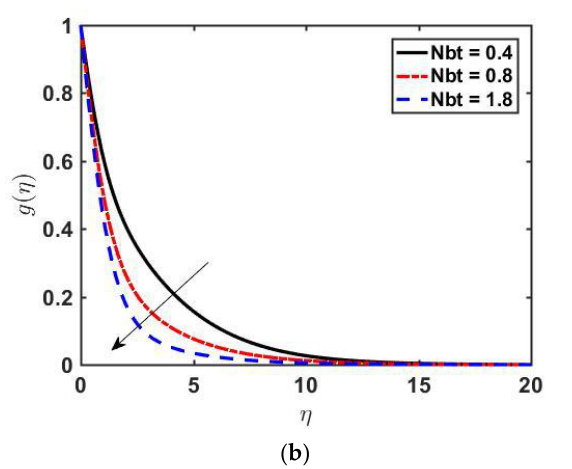
Figure 6. Profiles of θ ( η ) and g ( η ) versus η for various values of Nbt by fixing λ = 0.3, M = 0.5, Pr = 0.5, Le = 3.0, Nc = 0.5, and Sc = 2.0.